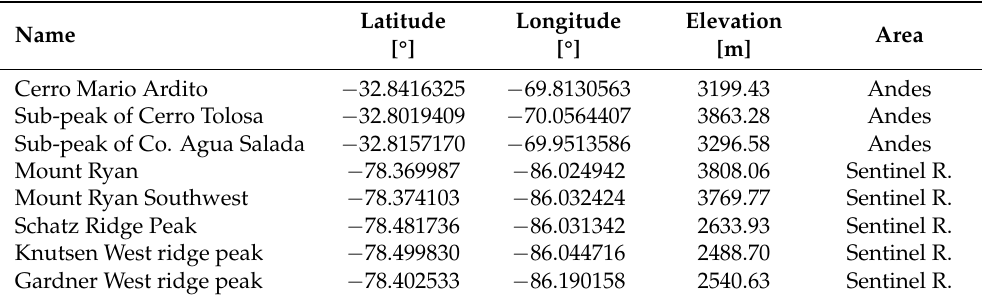
Figure 12. ASTER scene from 11 April 2004, used at the Andes validation site. Solar elevation for this scene was 41.3°, and the calculated refraction was 0.8 arcminutes. Red dots show all the features used as projectors in all four scenes at this validation site, and red lines show shadows used for validation in this scene. Next to each red line, the height differences between the shadow and projector are shown. For reference, we also show the position of the towns of Las Cuevas, Puente del Inca, and the Chile–Argentina border. Table 3. Location of peaks selected as projectors for the Andes and Sentinel Range validation sites. Values derived from field GNSS